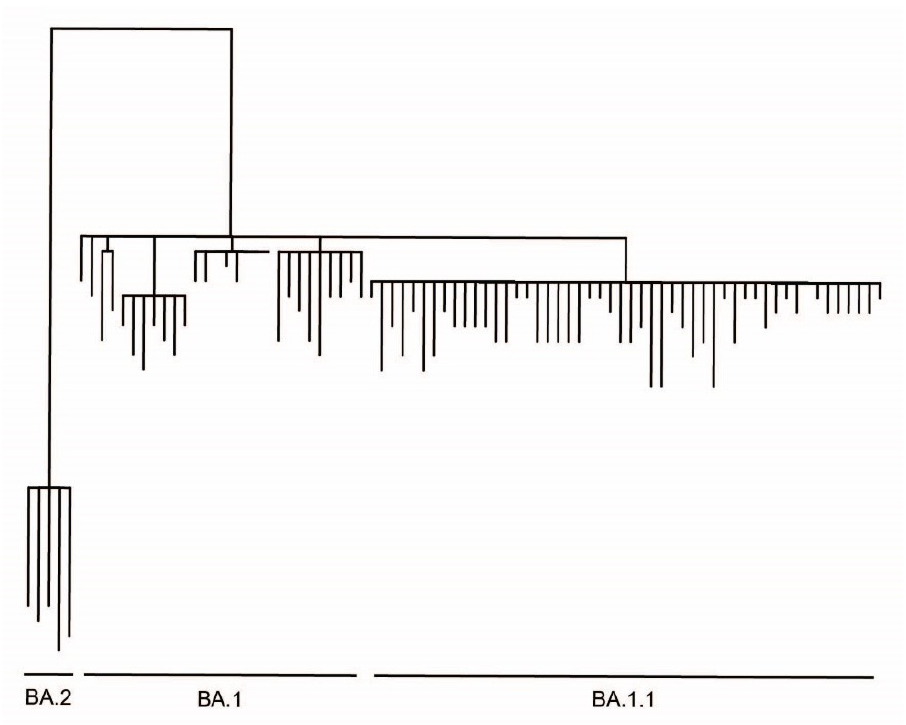
Figure 3. Phylogenetic analysis based on whole-genome sequences of SARS-CoV-2 Omicron variants detected in Santa Barbara County.